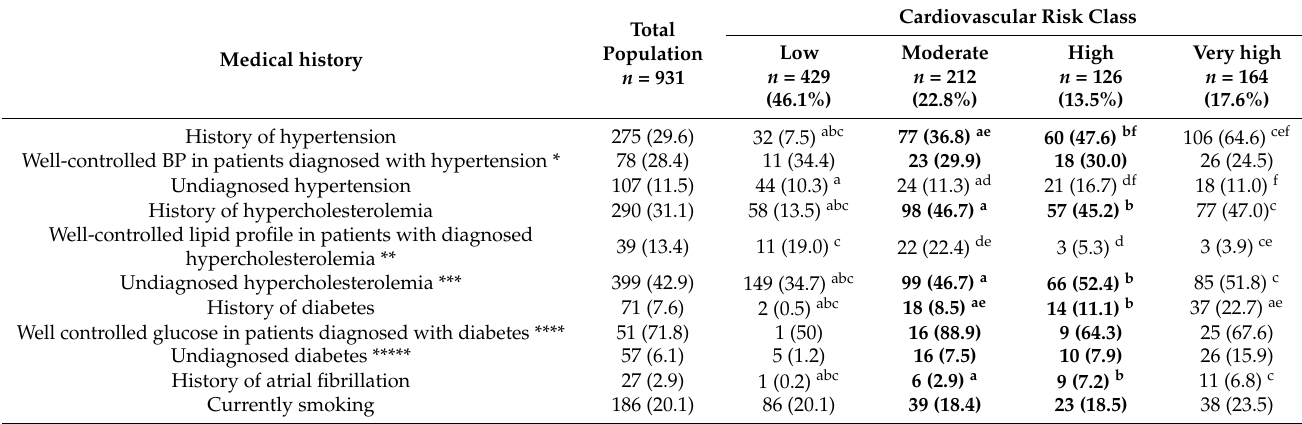
Figure 1. Schematic presentation of the relative differences in anthropometric ( a ), body composition ( a ) and laboratory parameters ( b–d ) between cardiovascular risk classes. The lowest value was assumed as 0% and the highest value as 100%. Table 3. Medical history of the total population and of subgroup according cardiovascular risk and comparisons variables between